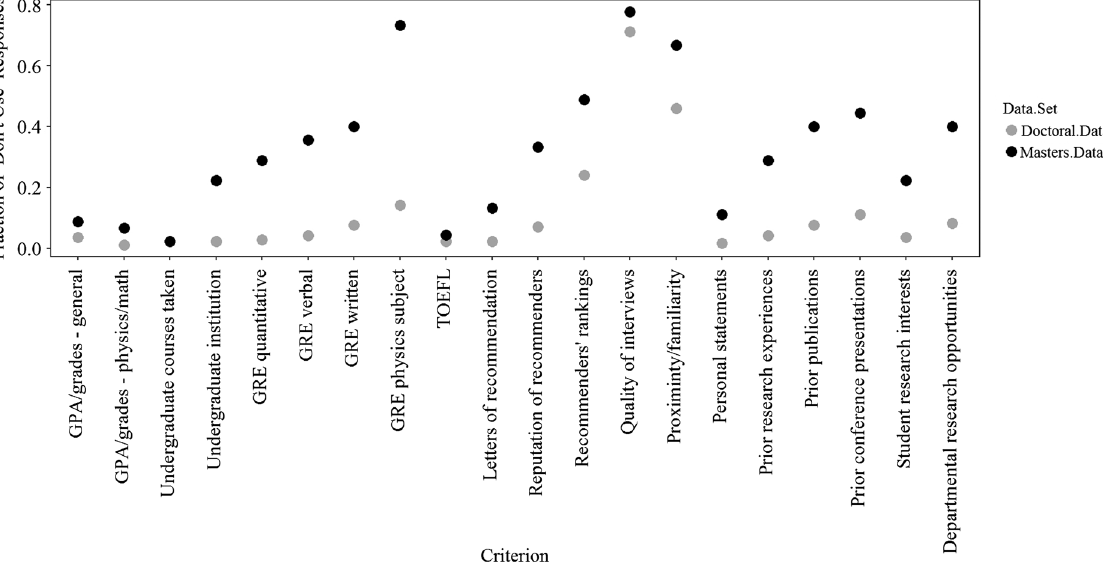
FIG. 3. Fraction of “ Don ’ t use ”